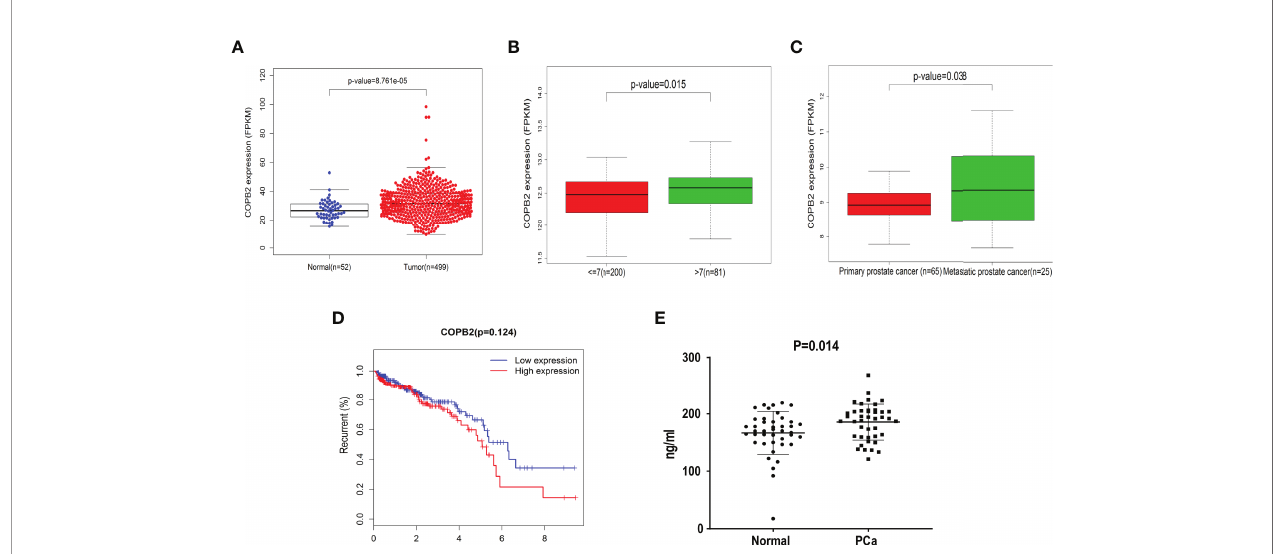
FIGURE 1 | Difference expression of COPB2 in clinical characteristics of PCa. (A) Expression of COPB2 between PCa tissue (499) and normal tissue (52) from TCGA cohort. (B) Level of COPB2 expression was analyzed in Gleason score ≤ 7 (200) and Gleason score > 7 (81) from GEO dataset (GSE16560). (C) Level of COPB2 expression was analyzed in primary PCa samples (65) and metastatic PCa samples (25) from GEO dataset (GSE6919). (D) An analysis of recurrence-free survival in patients with PCa by the Kaplan-Meier method. FPKM: Fragments Per Kilobase of exon model per Million mapped fragments. (E) The secretory of COPB2 in serum from peripheral blood between normal samples and PCa